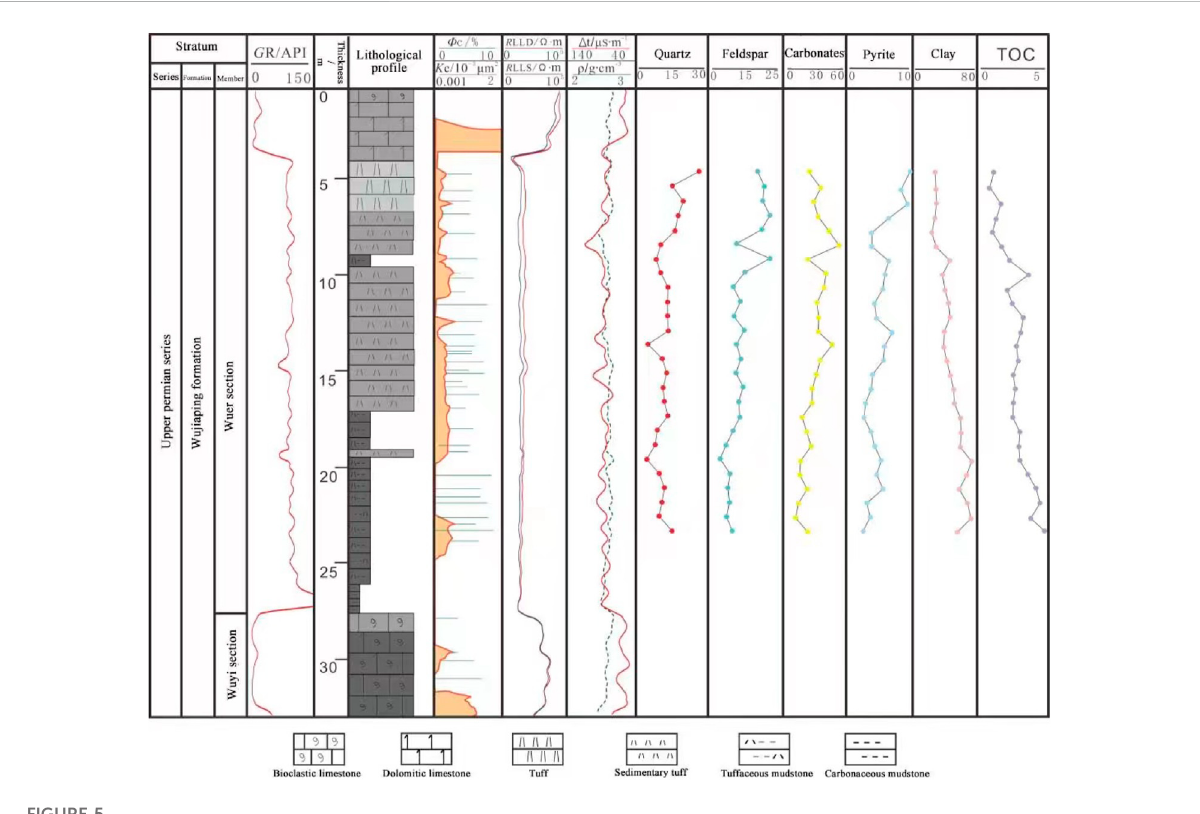
FIGURE 5 Main mineral composition of tuffaceous section of Y7